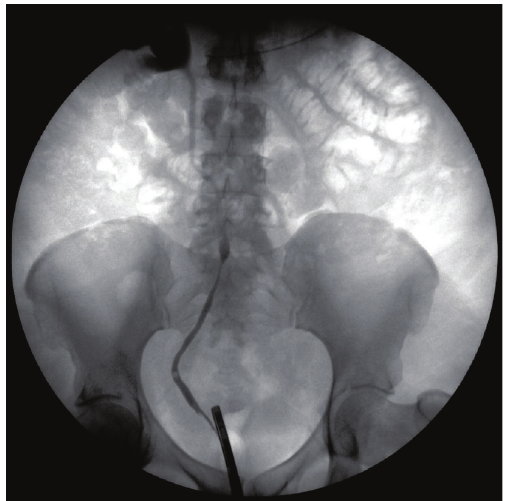
Figure 2: Retrograde pyelogram demonstrating evidence of extrin- sic compression and medial deviation of the right ureter.